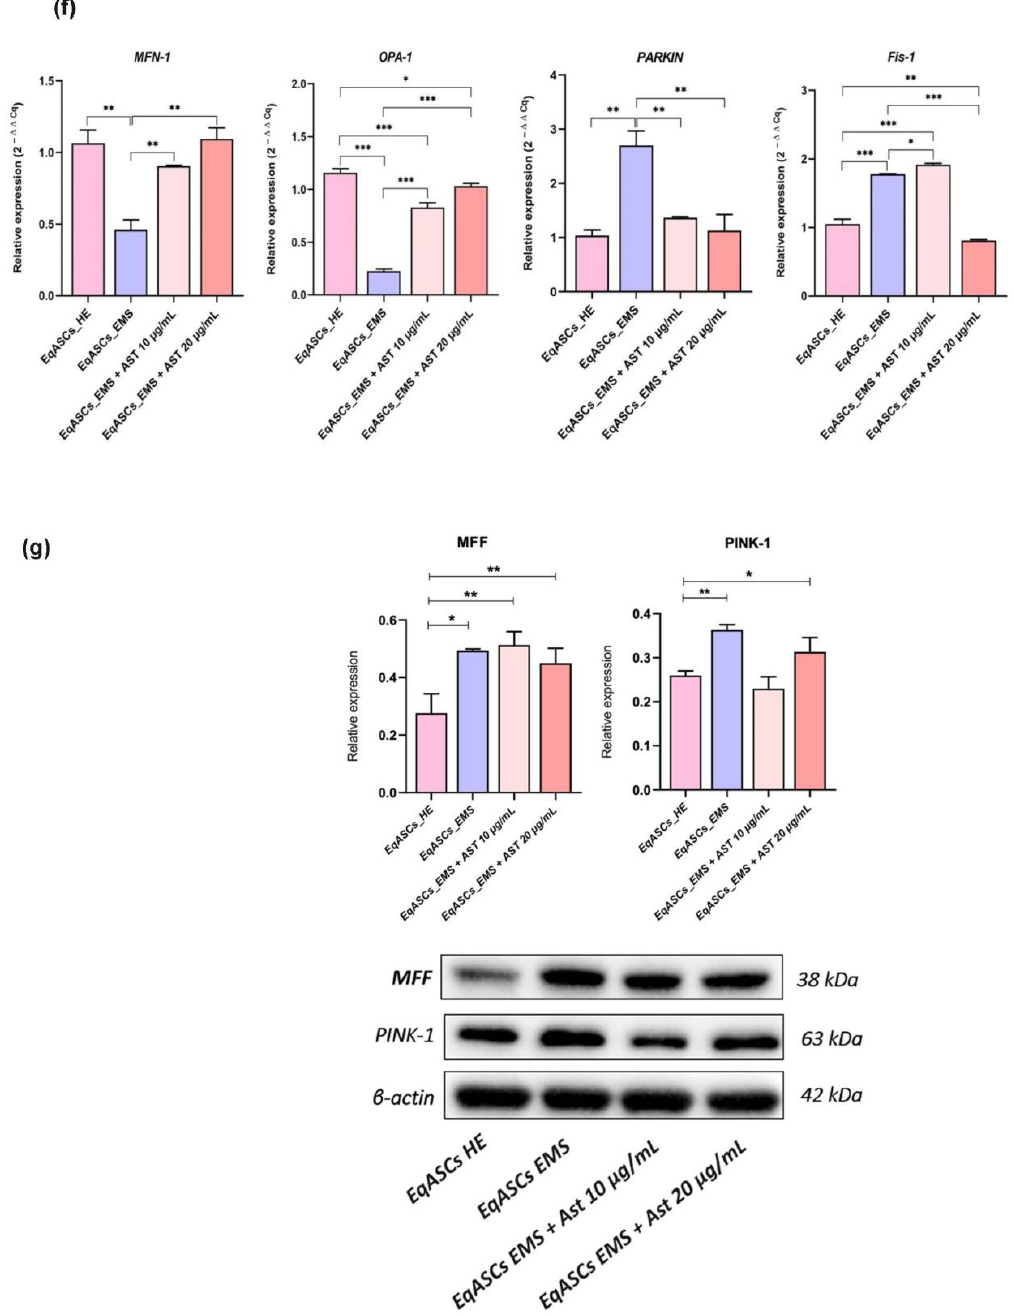
Figure 4. The effect of astaxanthin on mitochondrial dynamics in EMS ASC cells ( a ) Flow cytometric analysis of Mitochondrial membrane potential (MMP). ( b ) Percentages of total depolarized mito- chondrial membrane potential. ( c ) Epi-fluorescent confocal microscope images of MitoRed stained cells; scale bar size 25 µ m. ( d ) Imaris mitochondrial morphology analysis micrographs Mitochondrial morphology analysis. ( e ) Mitochondrial morphology analysis. ( f ) Representative Bar-Charts of the relative expression of mitochondrial fusion and mitophagy markers. ( g ) Levels of MFF, and Pink-1 were estimated with the western blot method. Relative expression was estimated using Image Lab software after normalization with β -actin (loading control). A comparison of EMS, treatment groups, and untreated healthy cells is shown by an asterisk (*). * p < 0.05, ** p < 0.01, *** p < 0.001. A hashtag (#) refers to a comparison of the EMS and astaxanthin treated groups. ### p <